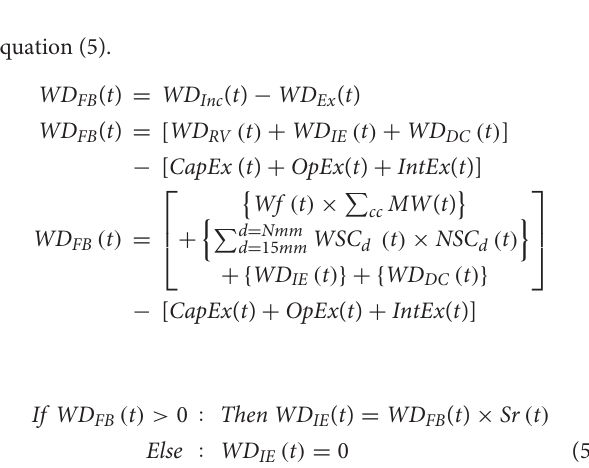
FIGURE 5 | Socio-political sector of the advanced system dynamic model in Stella ® .